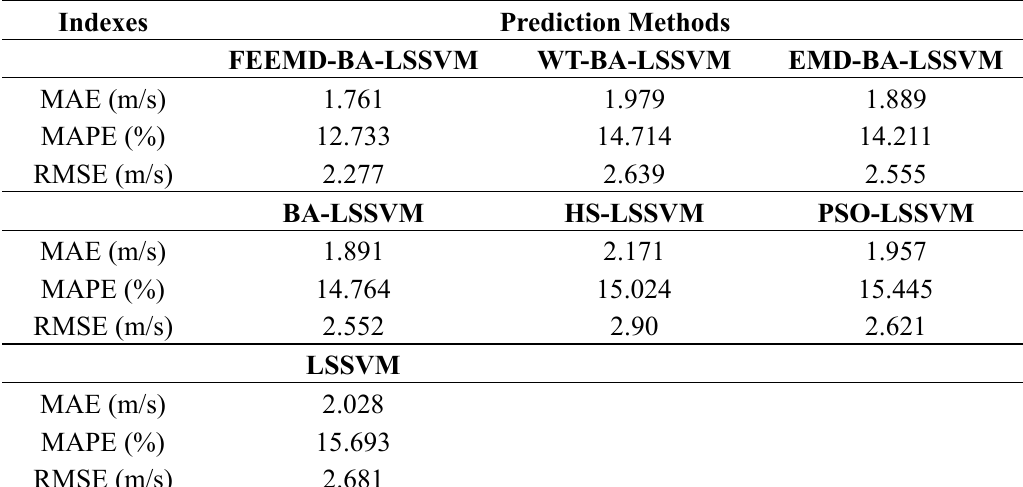
Figure 12. Forecasting results without temperature as argument. Table 7. Analysis of the predictions with temperature as argument.